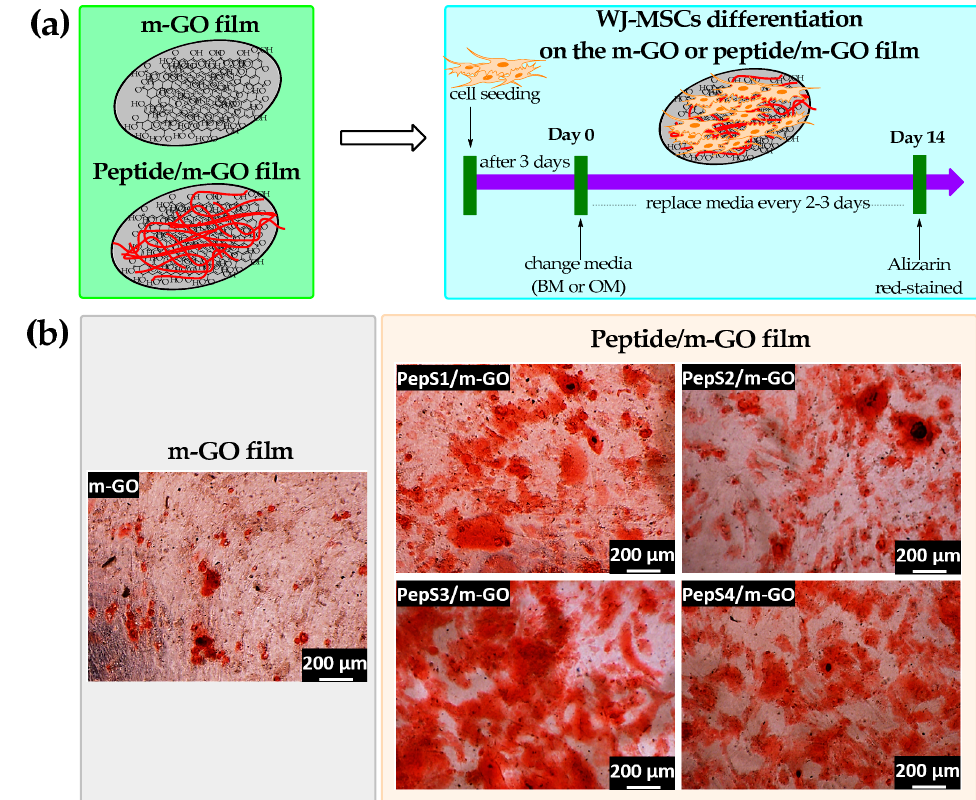
Figure 4. Peptide-conjugated m-GO film promotes osteogenic differentiation of WJ-MSCs. ( a ) Sche- matic demonstration of the procedure to differentiate WJ-MSCs into osteogenic lineages on the m- GO and peptide/m-GO film. ( b ) Alizarin Red staining of WJ-MSCs on the m-GO film before and after conjugate with peptide sequences (PepS1, PepS2, PepS3, and PepS4) after 14 days of osteogenic medium (OM) incubation. All scale bars represent 200